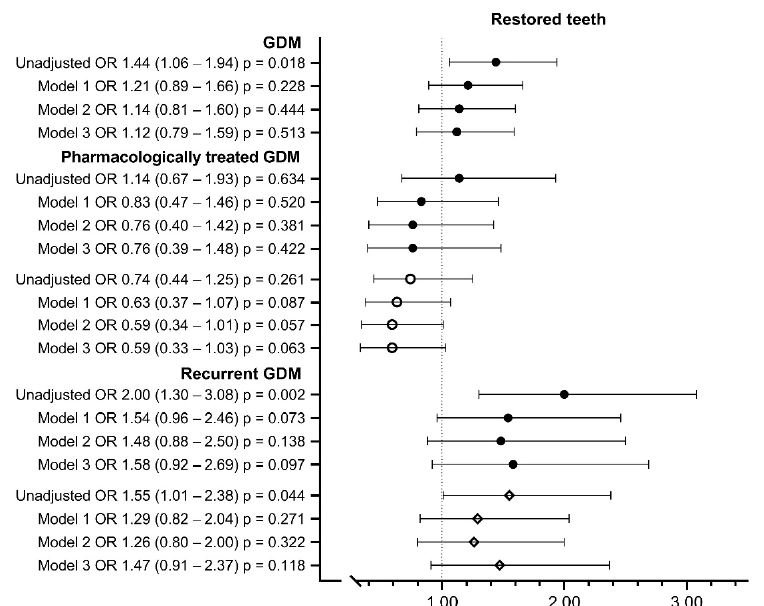
Figure 5. Number of restored teeth in women with gestational diabetes. Model 1 includes maternal age at birth and parity; Model 2 includes Model 1 + pre-pregnancy BMI; Model 3 includes Model 2 + smoking during pregnancy, educational attainment, asthma, insomnia and/or mental disorder and hyperemesis. ● Compared to controls. ◦ Compared to women with diet-treated GDM. ◊ Compared to women with first-onset GDM. Missing values were 6.5–8.1% in Models 1 and 2 and 12.2–13.2% in Model 3. OR, odds ratio; CI, confidence interval.